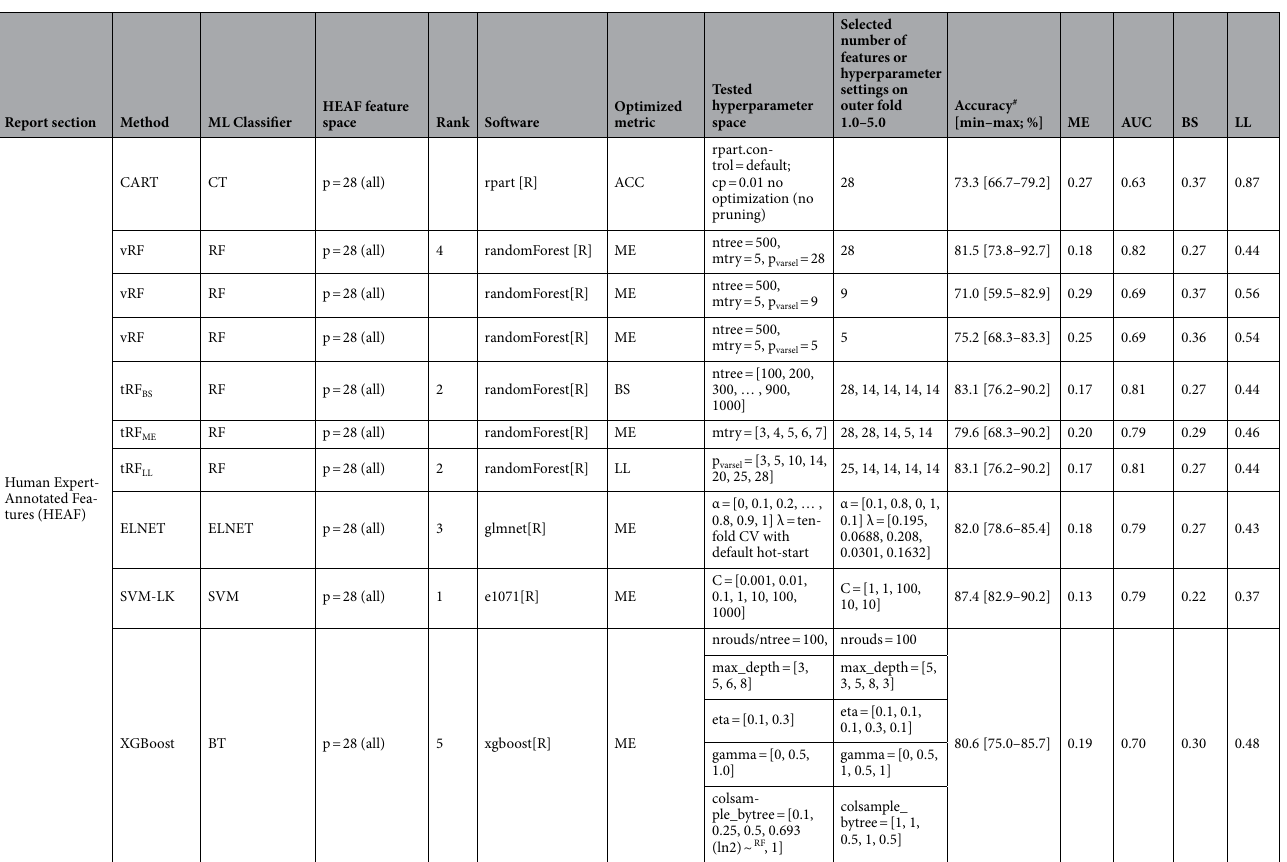
The mixing parameter alpha (α) was chosen 3 out of 5 times to fit ridge (0) or ridge-like (0.1, 0.1) models while twice to fit lasso (1) or lasso-like (0.8) models on the outer folds. On HEAF linear kernel SVMs (SVM-LK) achieved the highest fivefold CV accuracy (87.4%) and lowest BS (0.22) and LL (0.37) scores while obtaining a similar AUC of ~ 80% to other ML classifiers (Table 1). The tuning